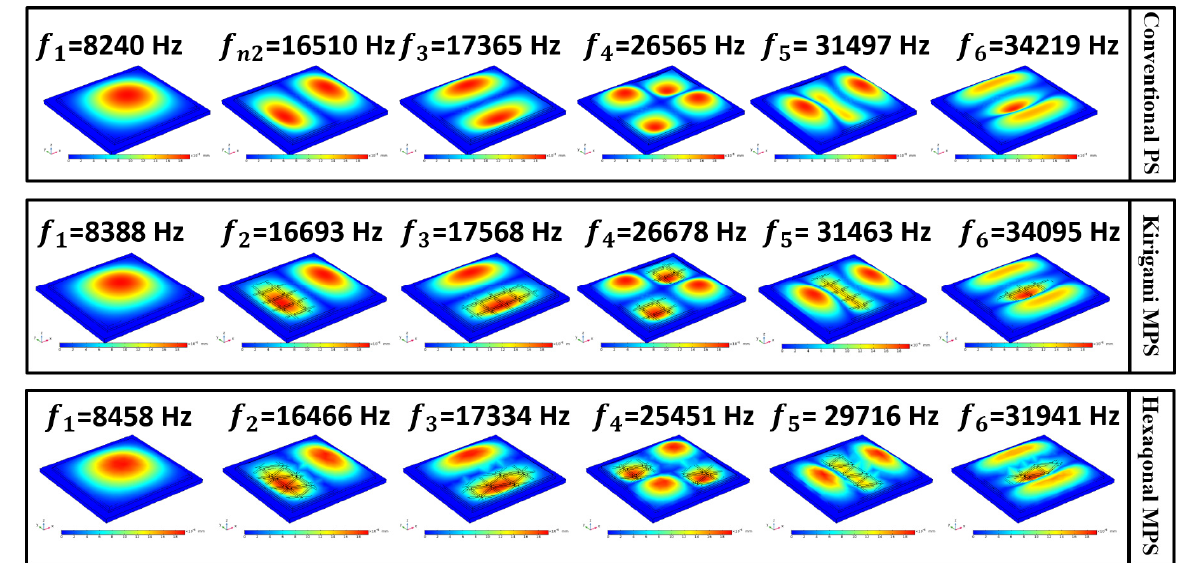
Figure 6. First natural frequencies and mode shapes of the three sensors.